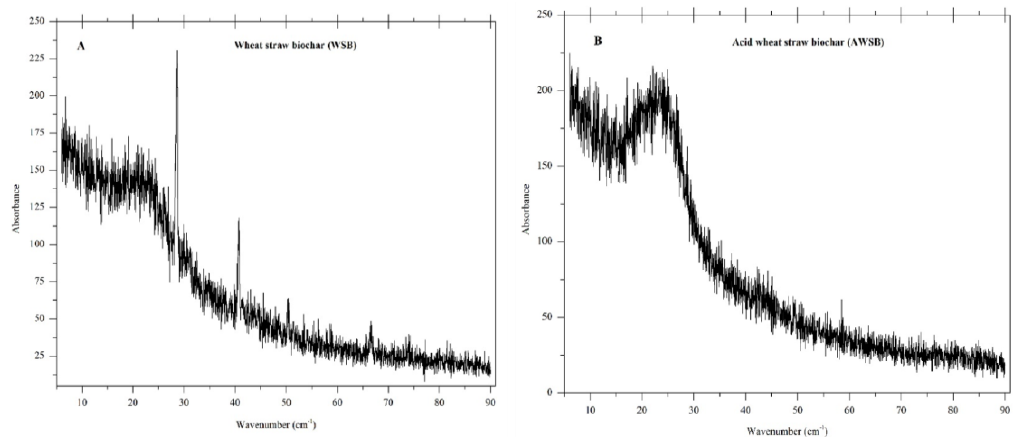
Figure 3. X-ray diffraction (XRD) patterns of wheat straw biochar ( A ) and acid activated wheat straw biochar ( B ) used for the removal of Cd from contaminated water.